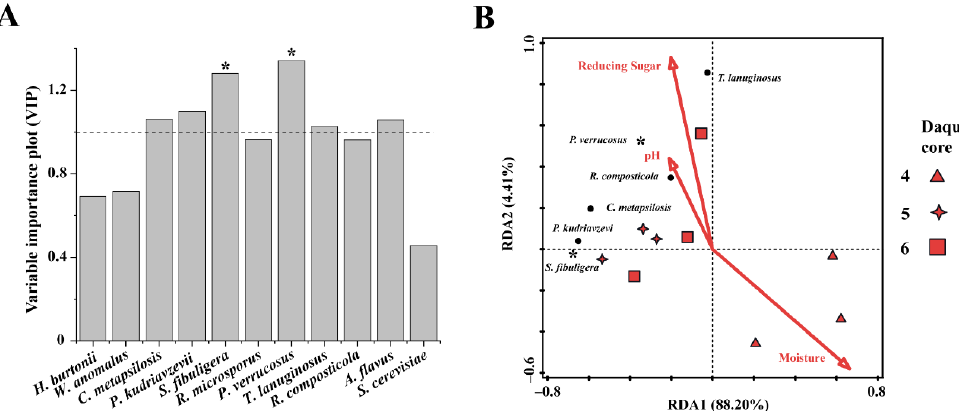
Figure 11. The initial formation of the Daqu core during fermentation. ( A ) The results of partial least squares regression between the Daqu surface and Daqu core. *: p < 0.05. ( B ) The results of partial least squares regression between the Daqu core in the fourth stage and Daqu core in the fifth~sixth stages.